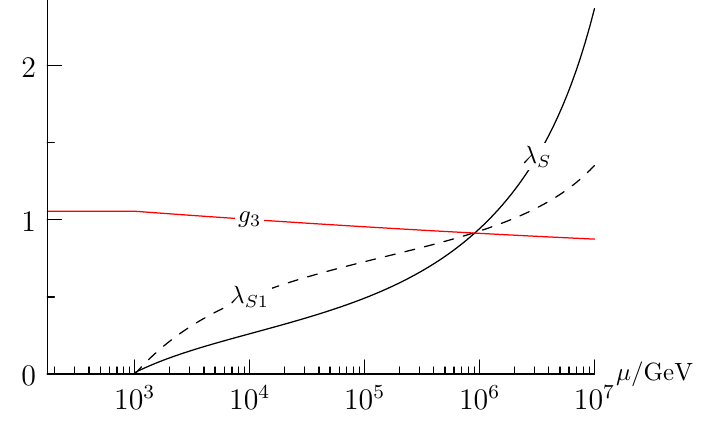
Figure 4 . The running of the scalar self-coupling (cid:21) simplicity. The (cid:12) -function (cid:12) (cid:21) remains small in a large energy range due to crossing zero twice. The scalar self-coupling (cid:21) S does not run, but walks .